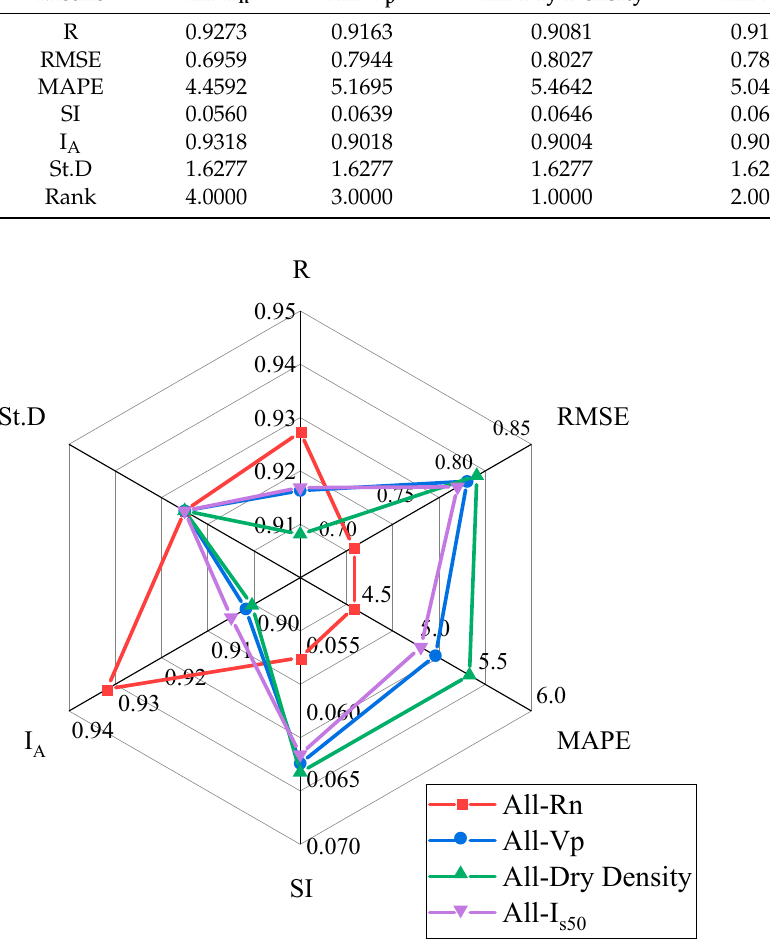
Figure 12. The influence input variables ranking for estimation of BI value.